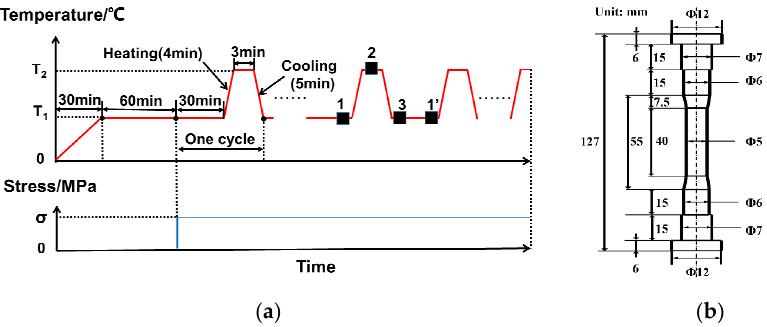
Figure 1. ( a ) procedure of the thermal cycling creep testing. ( b ) size of the thermal cycling creep specimen. Table 1. The creep testing conditions of the thermal cycling creep of K465